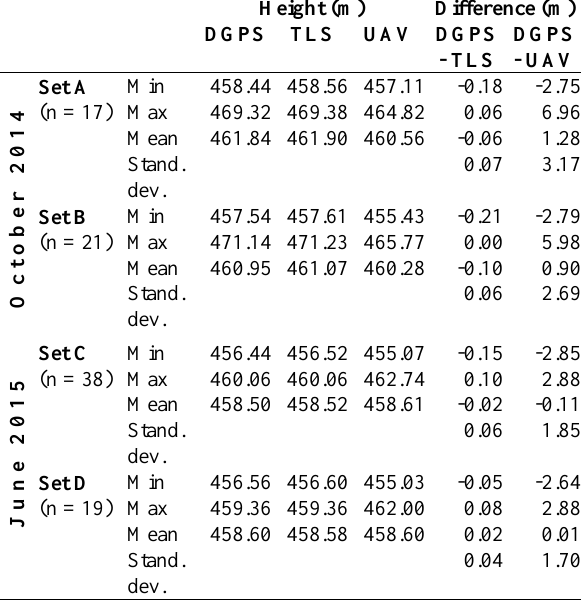
Table 2. Quality analysis of the DEMs, compared to DGPS reference measurements. Set A and B were used for DEM TLS_1 Figure 5. Difference between DEMs recorded in October 2014